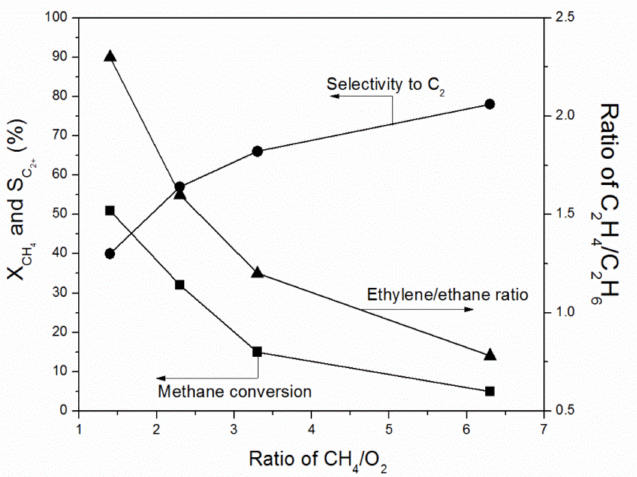
Figure 5. Influence of the methane/oxygen molar ratio on the OCM process. Source of methane— ”biogas 1”. Reaction conditions: T = 1053 K; GHSV = 11550 cm 3 · g − 1 cat · h − 1 ; m cat = 400 mg; total flow rate = 77 cm 3 · min − 1 , molar ratio of CH 4 :O 2 :CO 2 :He + N 2 = 1.4:1:0.5:4.6; CH 4 :O 2 :CO 2 :He + N 2 = 2.3:1:0.8:8.1; CH 4 :O 2 :CO 2 :He + N 2 = 3.3:1:1.2:12.4; CH 4 :O 2 :CO 2 :He + N 2 =